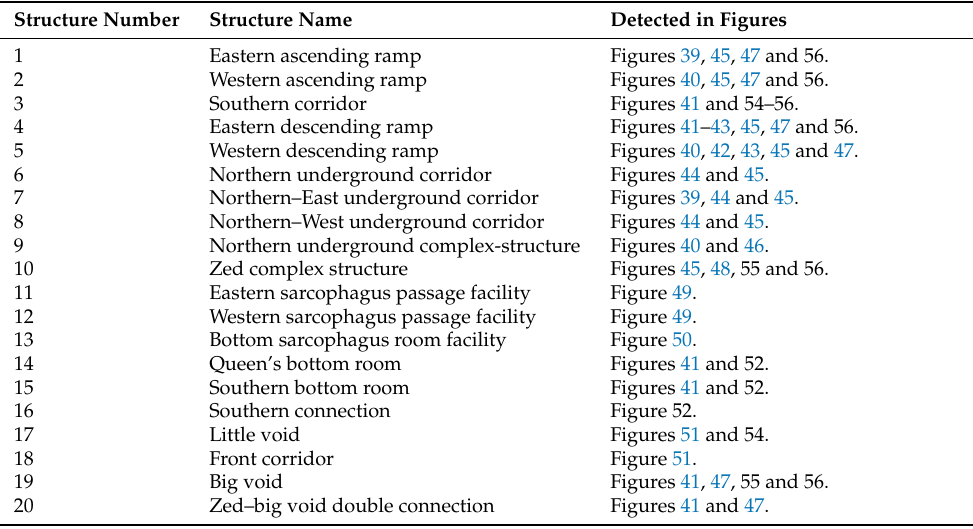
Figure 45. Tags association from tomography to 3D model. ( a ): Three-dimensional (3D) model of Khnum-Khufu (Top-side orientation). ( b ): Tomographic reconstruction (magnitude). Table 4. List of discovered structures detected in